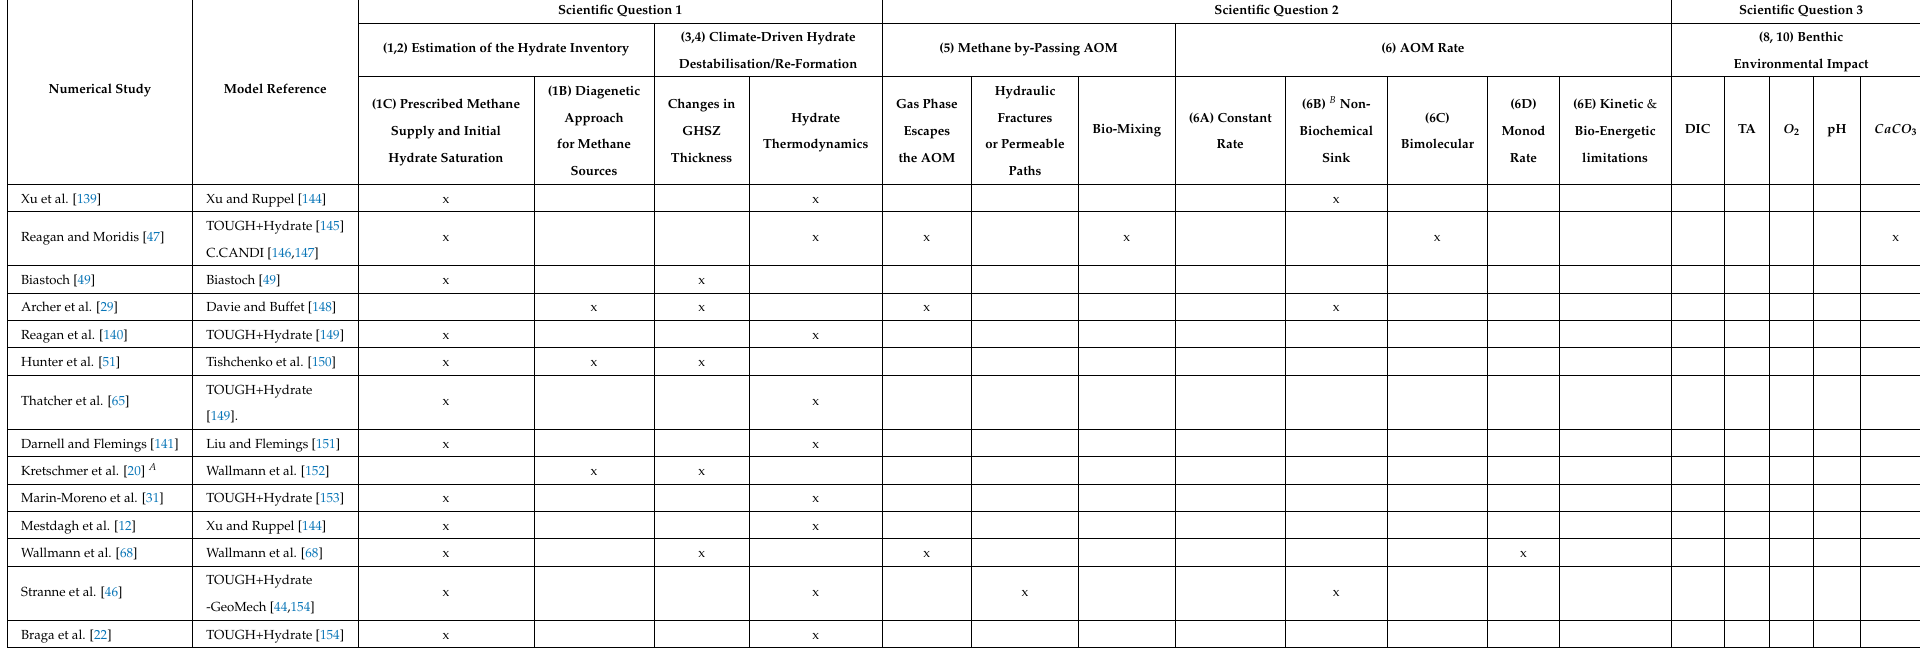
Table 3. Notable numerical studies investigating the sensitivity of marine methane hydrate to climate change. The “x” shows the level of complexity (increasing towards the right in the different sub-columns) in which the numerical models used in these studies simulate the different physical and biogeochemical processes involved in the 2 first scientific questions (see Section 3.1). Morover, the third main column details a broad range of chemical species and solid phases that models should trace in order to assess the benthic biogeochemical impact of hydrate-sourced methane turnover. Note that the numbers on the table can be related to those in Figure 9. Notation: A AOM is considered for estimating the initial hydrate inventory but is disregard when assessing methane efflux after hydrate destabilisation, B the AOM rate is formulated based on pore-space methane dissolution principles that do not consider biochemical processes. DIC: Dissolved Inorganic Carbon, TA: Total Alkalinity, O 2 : Dissolved oxygen, CaCO 3 : Authigenic